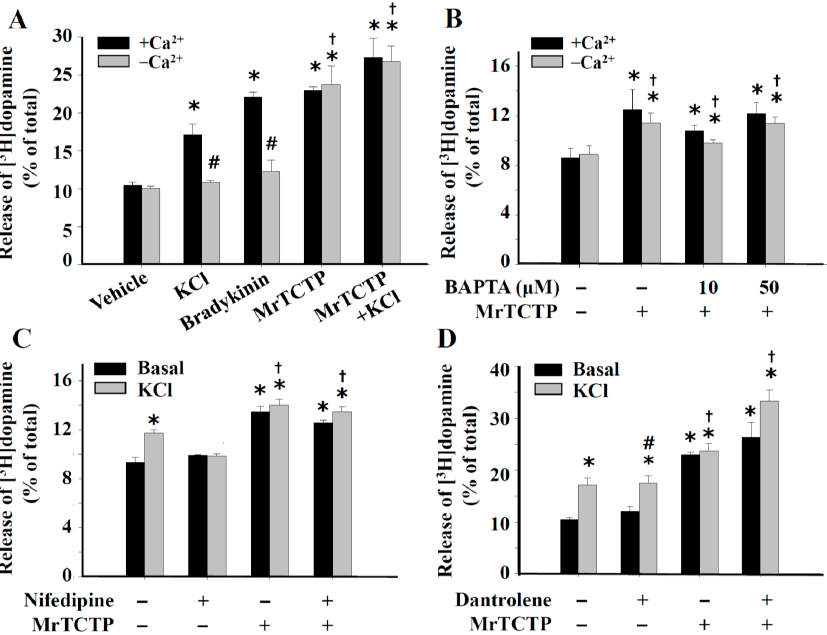
Figure 4. TCTP induced dopamine release from PC12 cells via Ca 2+ -independent